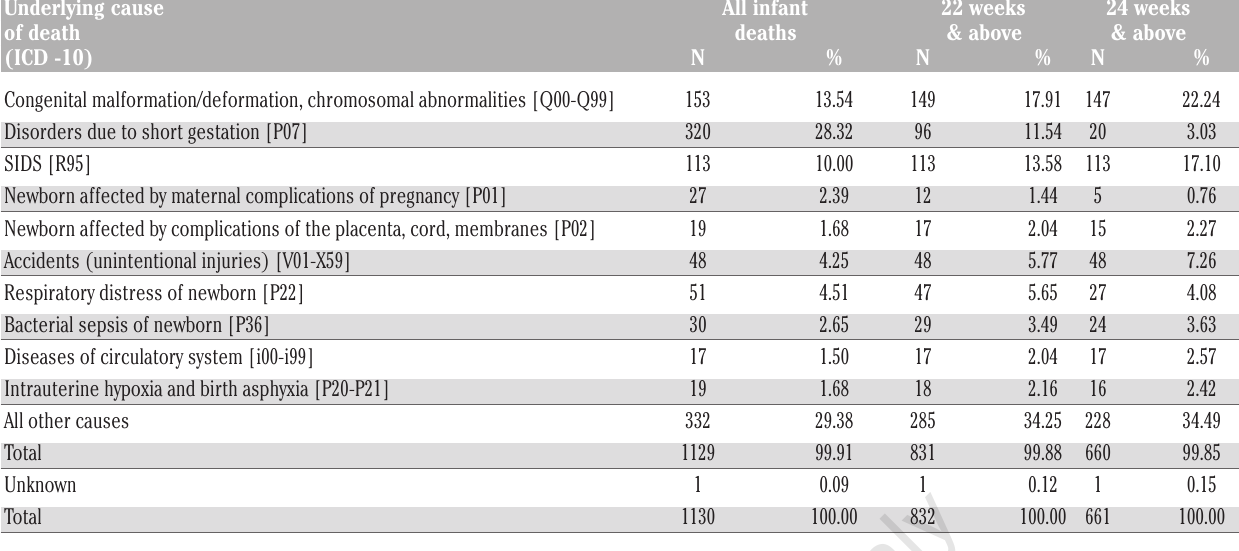
Figure 6. 1999- 2004 IMRs in Shelby County, TN, by variables gestational age and birthweight criteria.